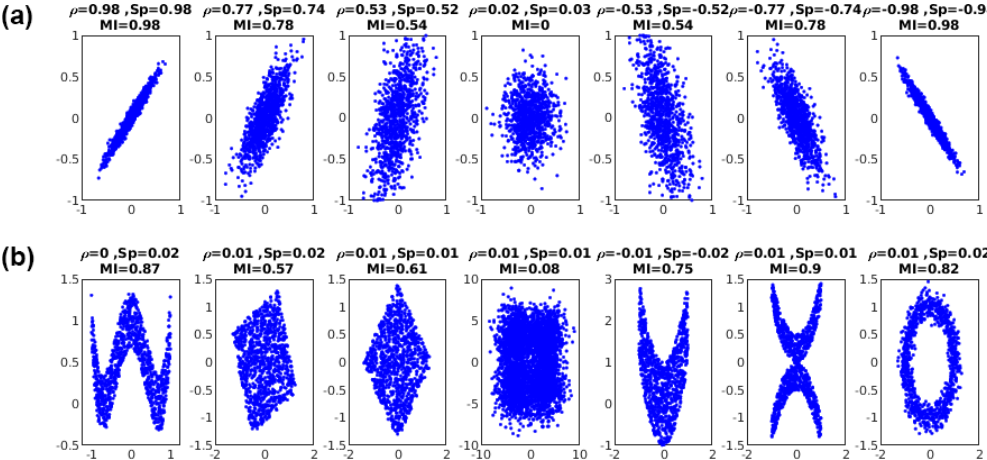
Figure 3. Mutual information (MI) vs. Pearson ( ρ ) and Spearman ( Sp ) correlations tested on linear (a) and non-linear (b) data sets. It can be seen that both methods are able to estimate the correlation for the linear case. On the other hand, the Pearson correlation fails in estimating the correlation for the non-linear data sets, whereas MI is capable of estimating the existence of correlation even in these cases. The so-called nearest-neighbour implementation of the mutual information method is used here (see